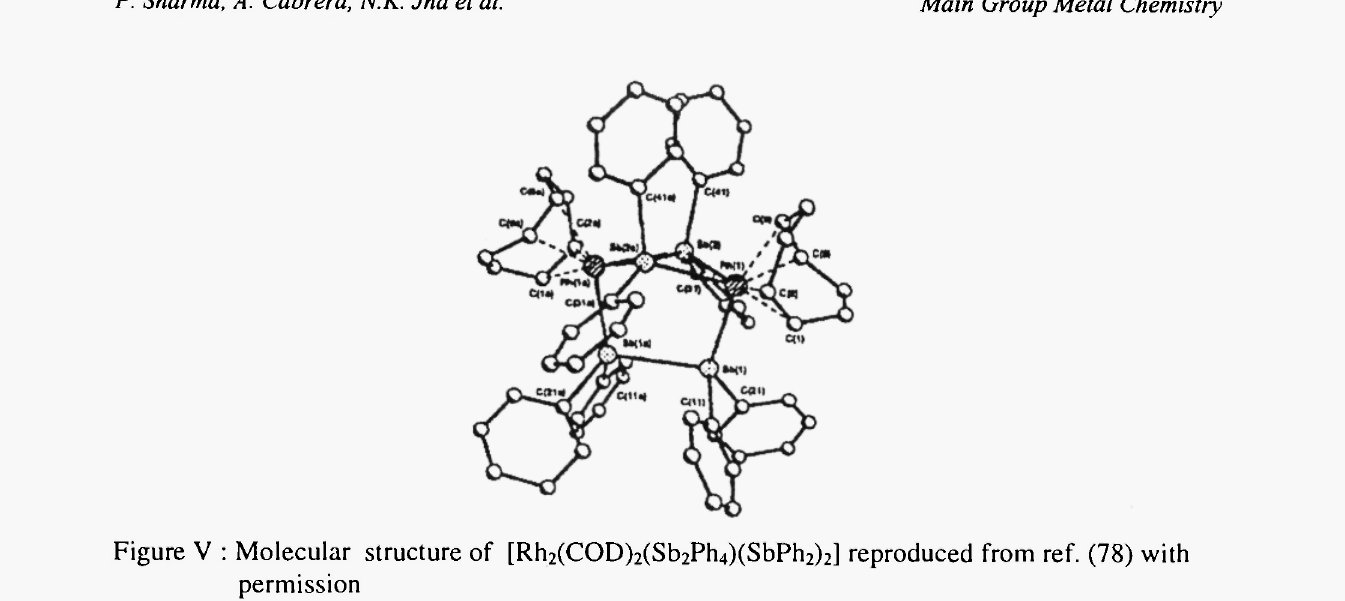
Figure V : Molecular structure of [Rh 2 (COD) 2 (Sb2Ph 4 )(SbPh2)2] reproduced from ref. (78) with